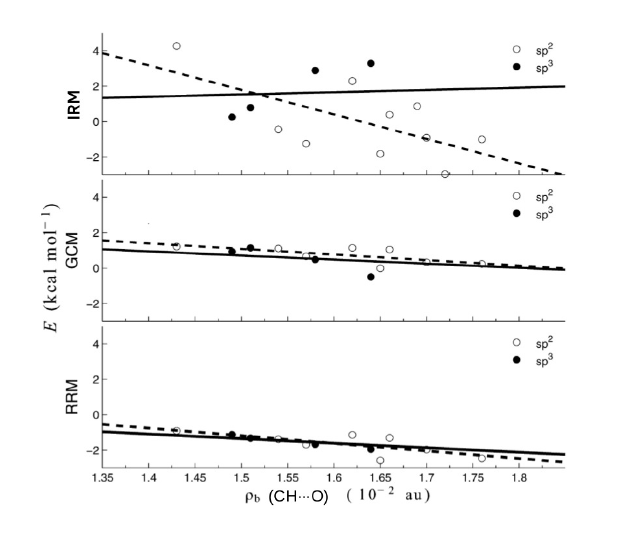
Figure 22. Correlations between RRM-, GCM-, and IRM-based interaction energies of C-H · · · O contacts featuring either sp 2 (open circle) or sp 3 (full circle) hybridized carbon atoms and the electron density at the bond critical points of these contacts